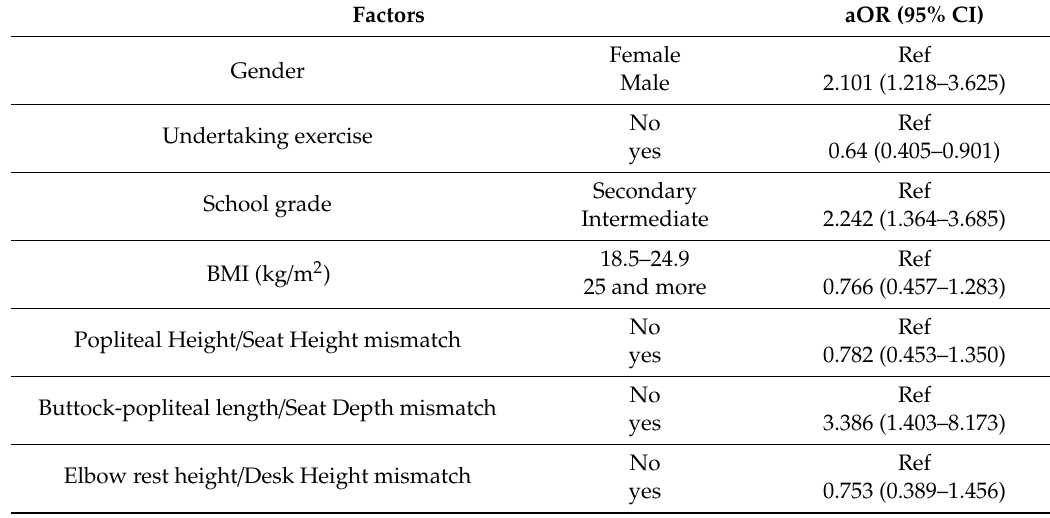
Table 3. Personal and school furniture mismatch factors associated with back pain related to long sitting at school among the study sample of adolescents ( n =